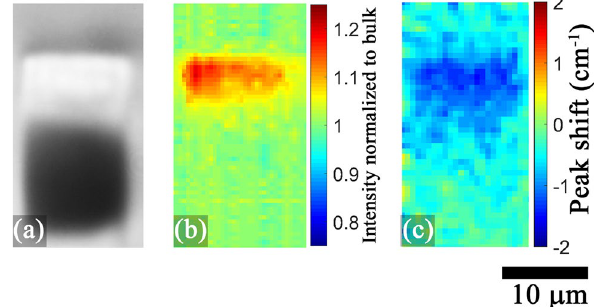
− 1 Figure 9. ( a ) DIC image ( b ) 575 cm Raman peak intensity and ( c ) its frequency shift of the 12 μm wide waveguide (0.6 μm pitch) written at a rep. rate of 5 kHz and 700 nJ pulse energy in the 45HfF 4 –10ZrF 4 –45BLAN glass.